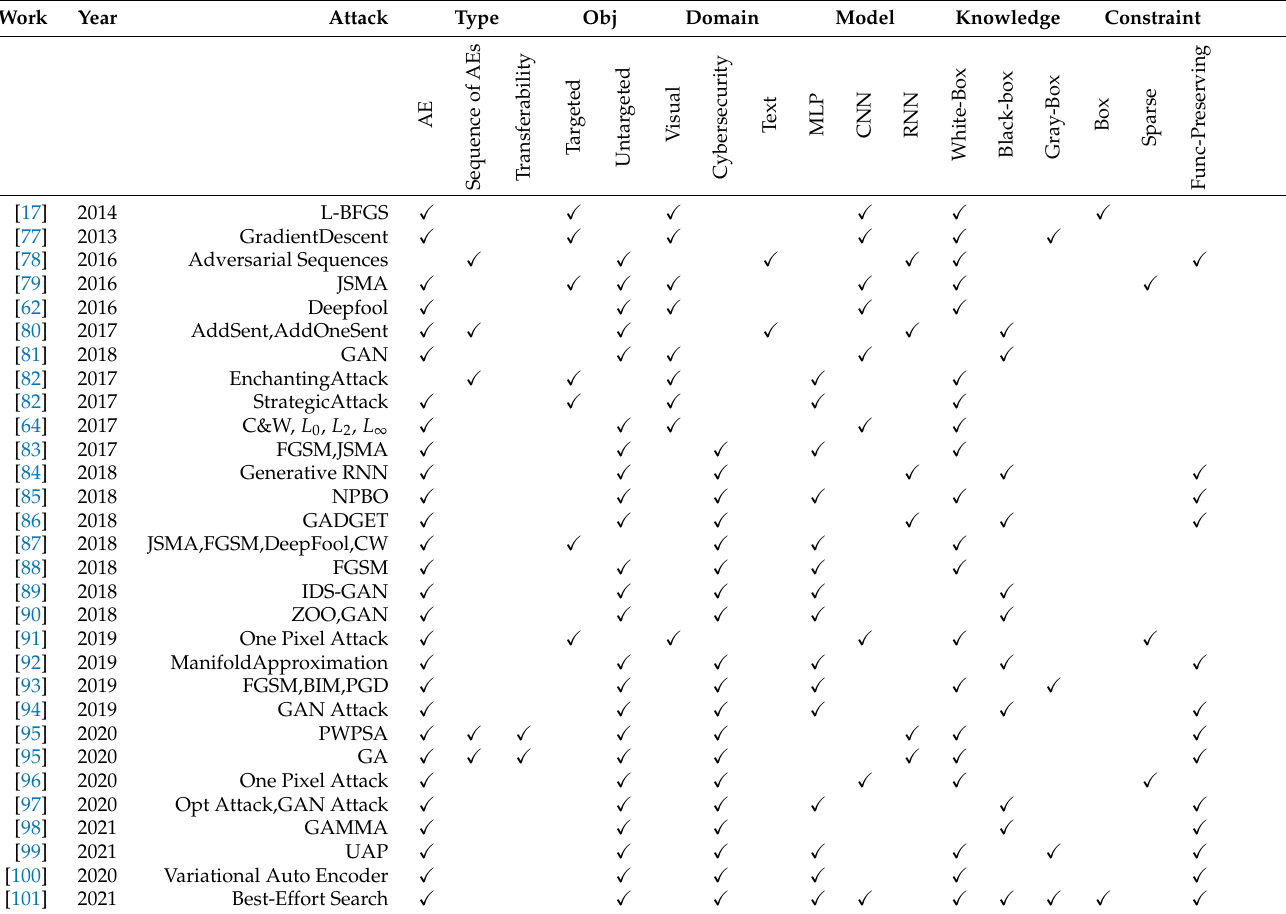
Table 5. Chronologically ordered summary of adversarial example